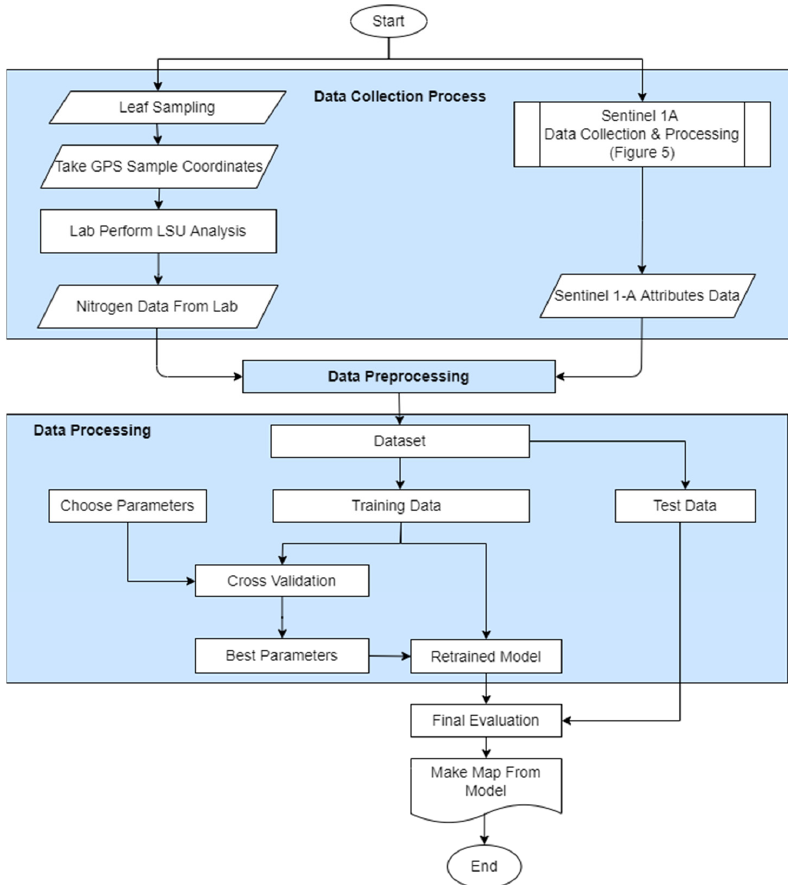
Figure 3. Research design.